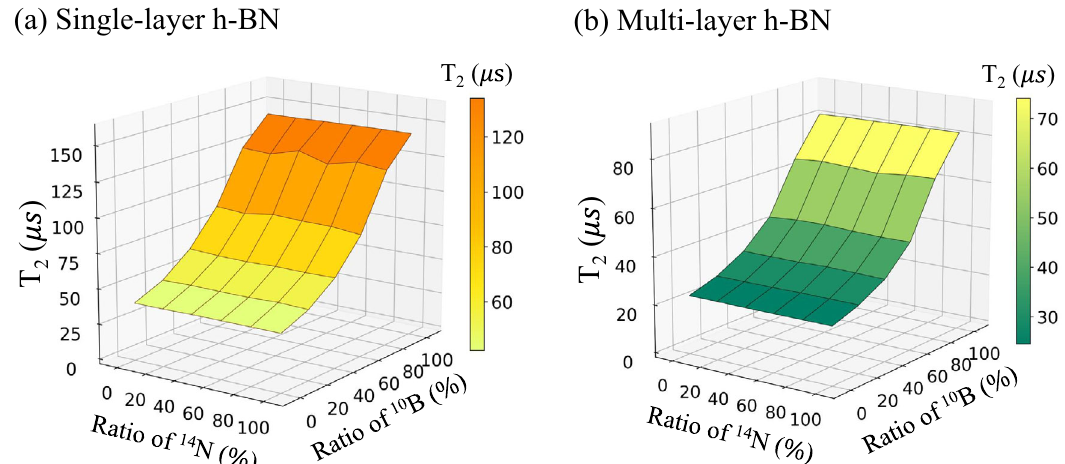
Fig. 2 Enhancement of T 2 in h-BN via isotopic engineering. a , b Computed T 2 of the V B − spin in a monolayer h-BN and b multi-layer h-BN as a function of the ratio of 14 N and 10 B nuclei in the lattice. An external magnetic fi eld of 3 T is applied. The maximum T 2 time is obtained when h-BN is 100% enriched with 10 B both in the single- and multi-layer con fi gurations, yielding a T 2 of 143 μ s and 81 μ s, respectively.